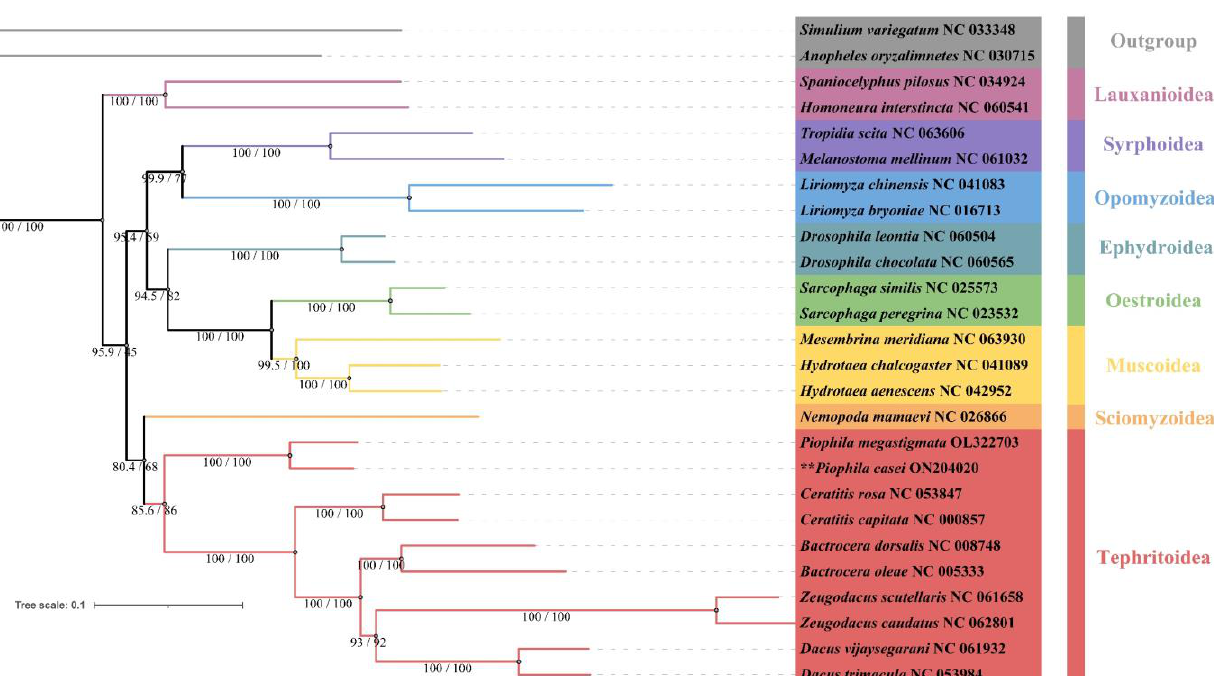
Figure 8. A genome-wide phylogenetic tree of the mitochondria of 26 dipteran insect species con- structed based on ML analysis. Two values of developmental dendrites (SH-aLRT support/boot- strap support). (The specie marked with ** is the main subjects of study in this research).